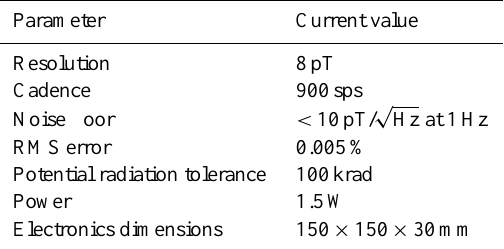
Table 2. Performance summary of the prototype